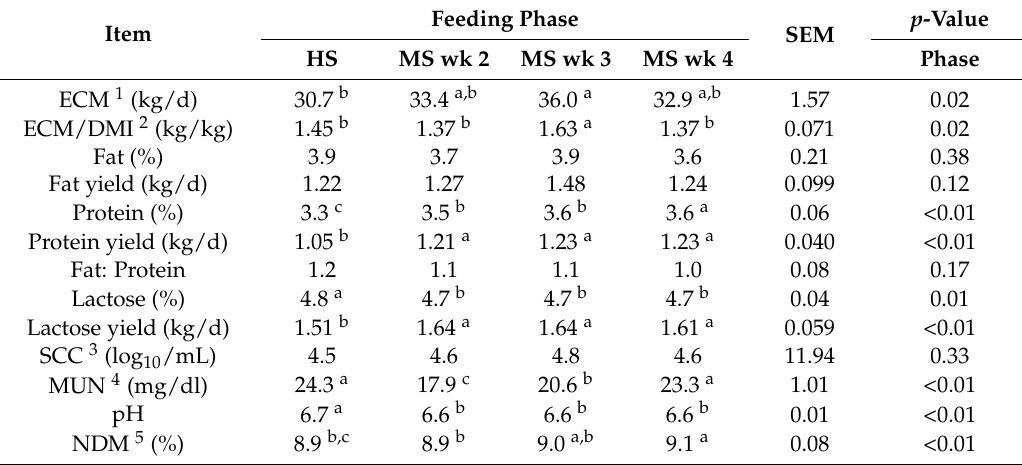
Table 5. Effects of the feeding phase on milk composition in cows fed either a 40% concentrate diet high in physical structure (24.4% peNDF > 8 mm DM basis; HS), or a 60% concentrate diet with moderate physical structure content (17.6% peNDF > 8 mm; MS wk 2–4).